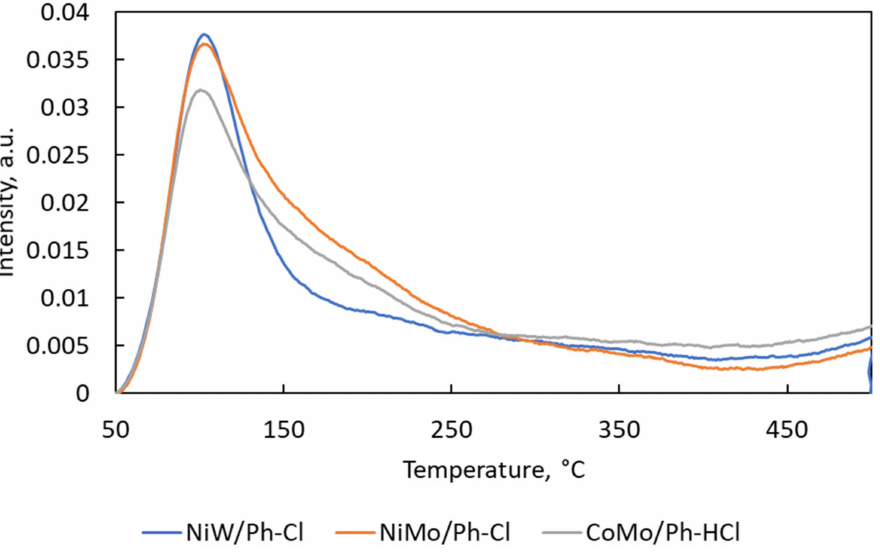
Figure 3. NH 3 -TPD profiles for all the